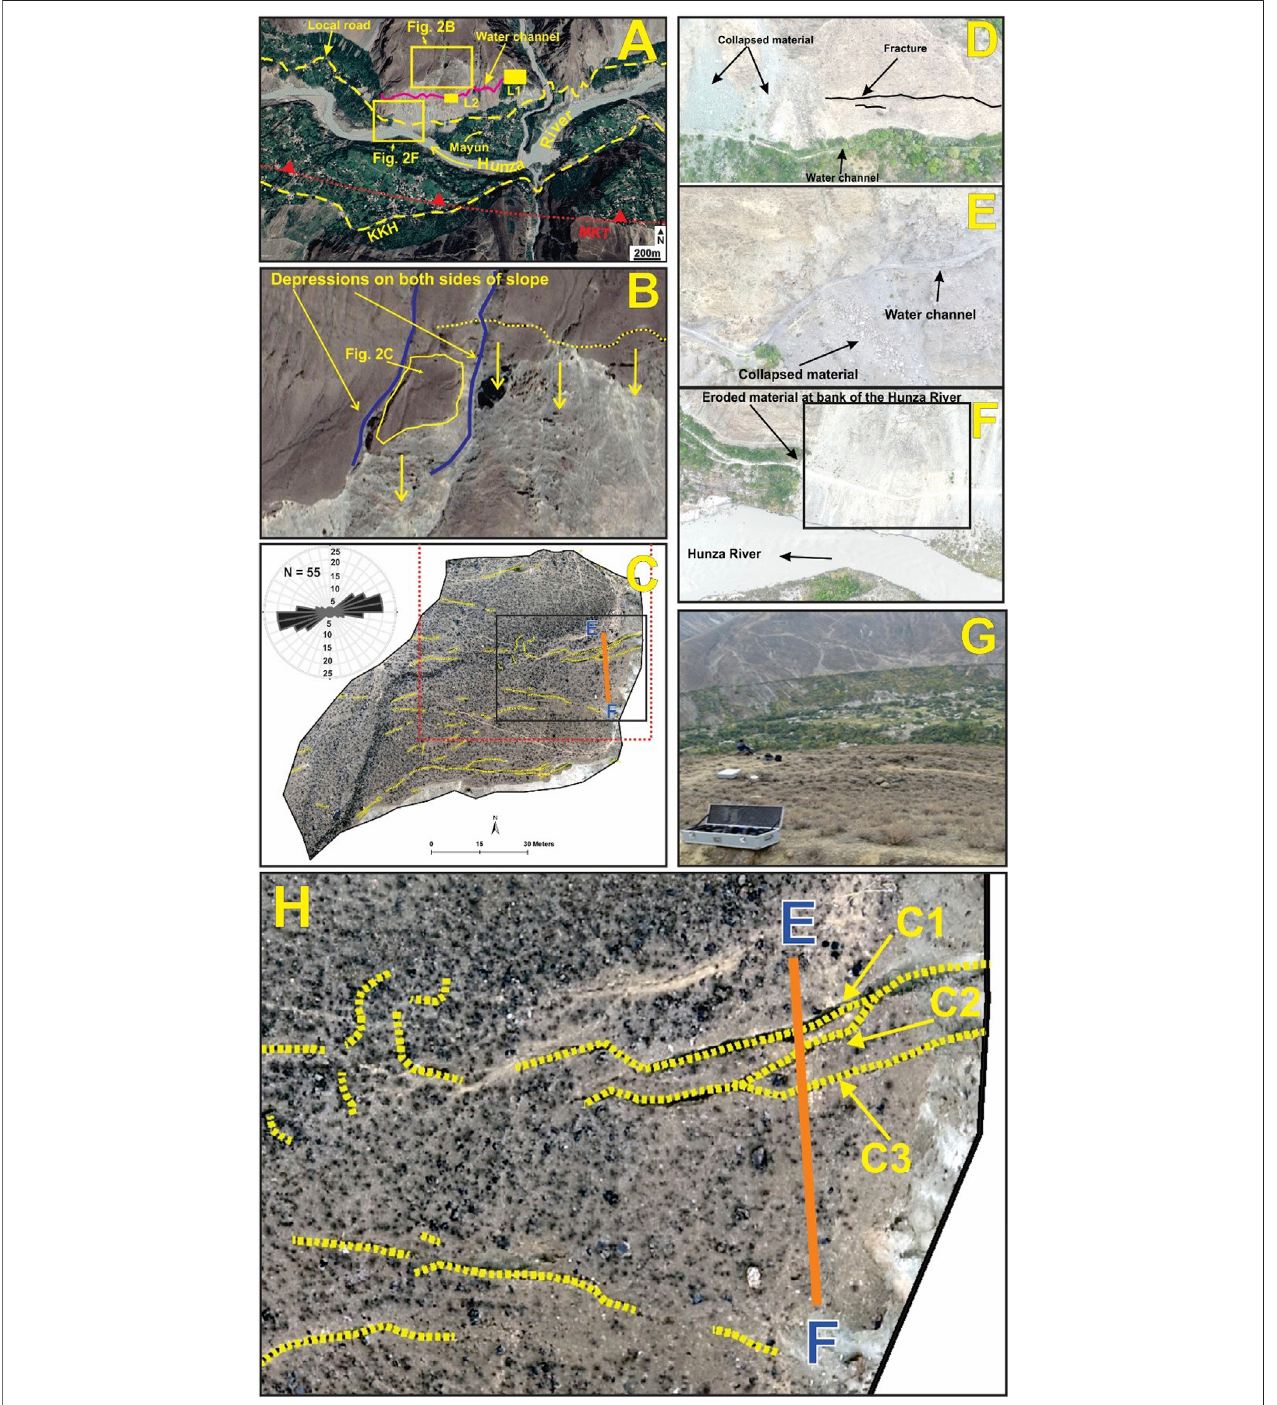
FIGURE 2 | Google Earth imagery (A , B) with larger features (MKT, KKH, local road, the Hunza River, and Mayun village) shown in Panel 2 (A) and Mayun slope- speci fi c features (its location as 2 (C) ); depressions denoted as solid blue lines represent depressions/tributaries, dashed-yellow line denotes the E-W oriented deformation in the upslope direction, and the solid yellow lines show the main sliding direction in Panel 2 (B) . Geomorphological features on UAV aerial photographs (C , D , E , F) , the Mayun slope overview while standing at the crest and looking southward towards the downslope area (G) , and adjacent area towards the Hunza River. Filled rectangles with yellow color (L1 and L2) in Panel 2 (A) represent locations of Panels 2 (D , E) , respectively. In Panel 2 (C) , red dotted box denotes the extent of Figure 4A ; solid black box represents the extent of Panel 2 (H) (zoomed-in view of the Mayun slope showing details of GPR pro fi le and marked cracks); yellow dotted lines represent cracks on the surface; a rose diagram shows their orientation. Panel 2 (H) shows GPR pro fi le (EF).